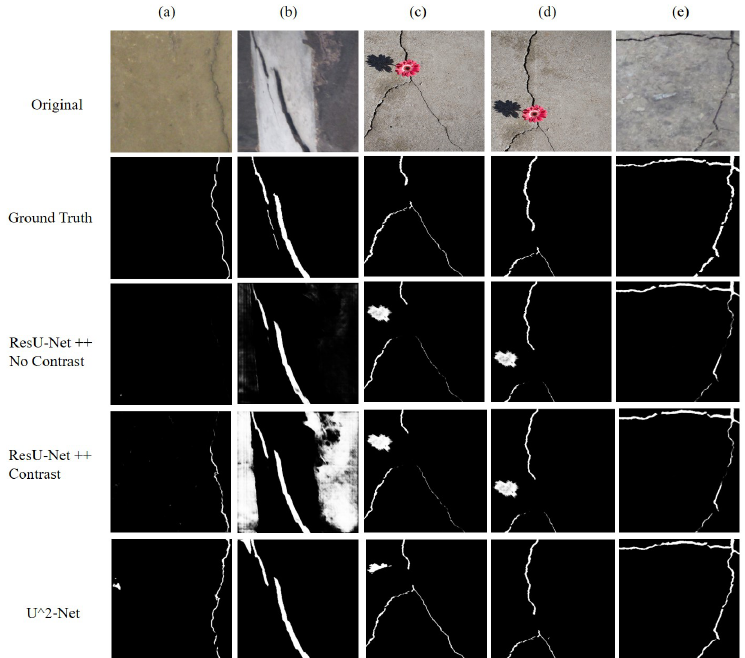
Figure 12. Results on several samples of the used crack detection dataset, with different patterns— group1. In each column, we present the results based on: ( a ) Blurred image with a crack, ( b ) Wide crack with a marker, ( c ) Branched crack with a flower, ( d ) Branched crack with flower (a different point of view), ( e ) Branched crack.